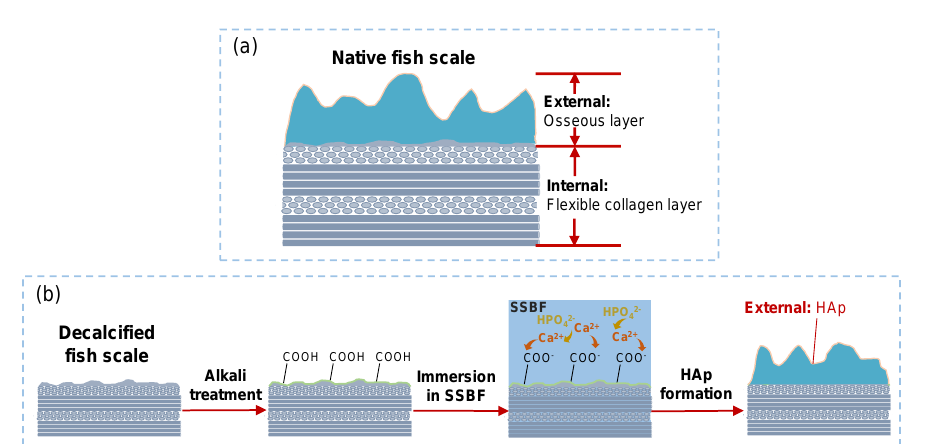
Scheme 1. Illustration of the possible cross-sectional structures of ( a ) native fish scale and ( b ) the mineralization process of the decalcified fish scale treated with alkali and immersion in SSBF.